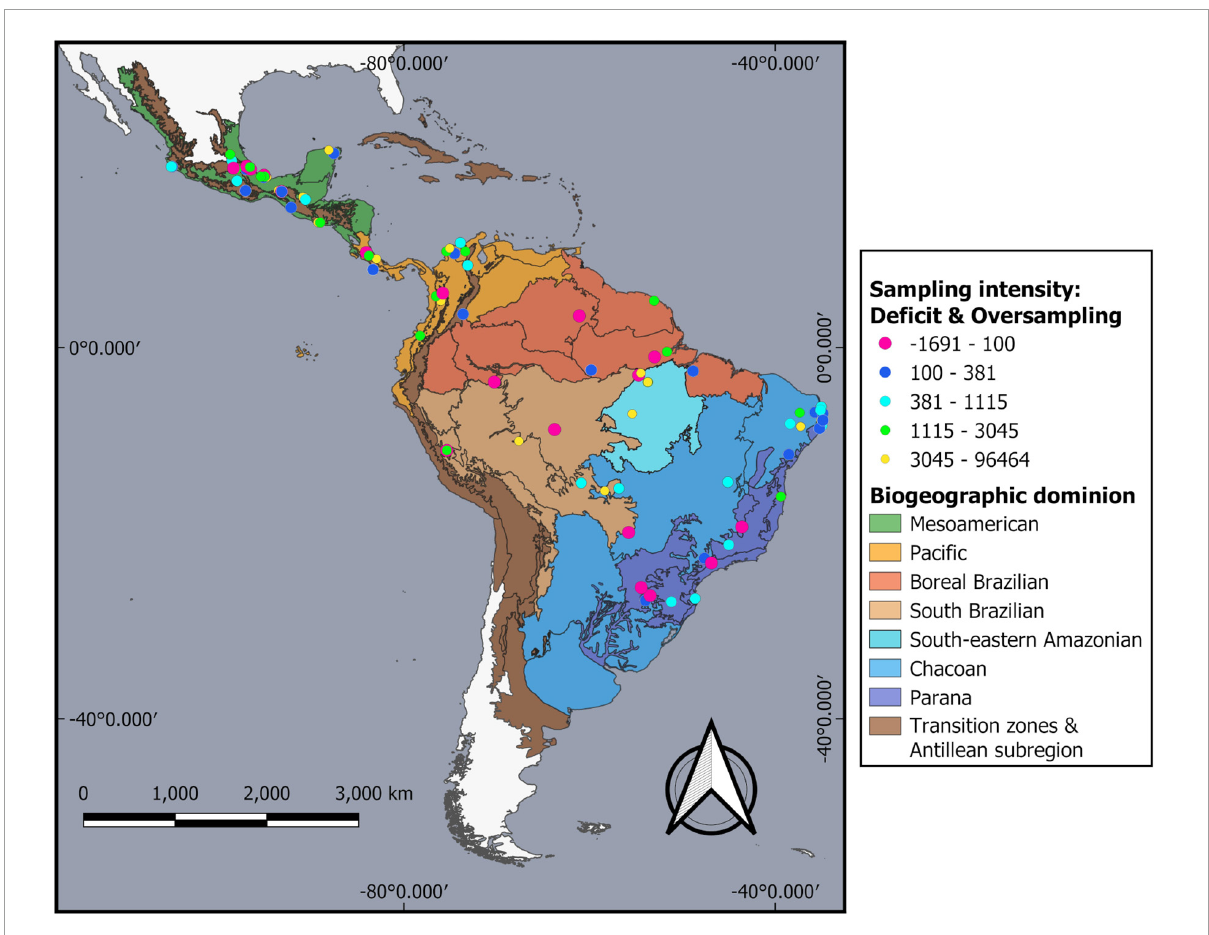
FIGURE2 Geographic distribution of the sites studied. Sampling intensity is reported for each study site. The sampling deficit shows those sites where the sample did not reach 99% completeness, with negative values representing the effective abundance deficit per sampling site. Oversampling shows those sites where the sample exceeded 99% completeness, indicating the excess abundance per sampling site. Vector image from Morrone et al. (2022).